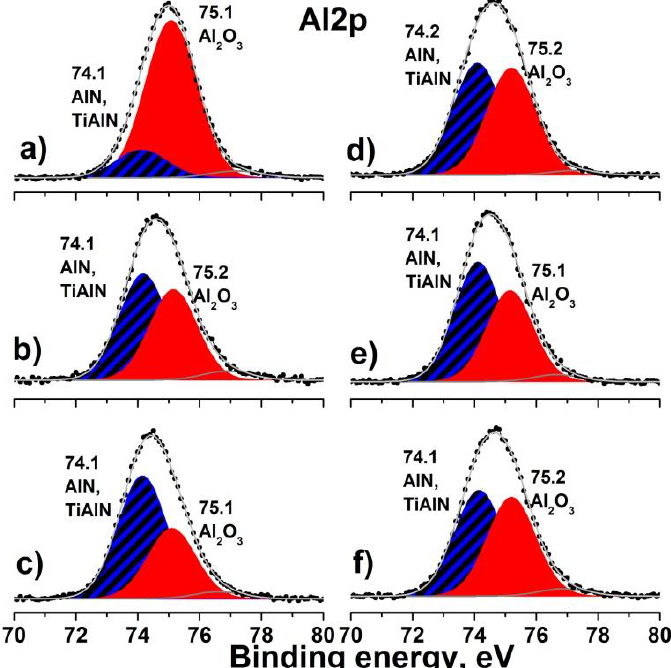
Figure 4. Al2p XP-spectra obtained for Ti-Al-N films ( a ) 200 ◦ C, 20 sccm; ( b ) 200 ◦ C, 40 sccm; ( c ) 200 ◦ C, 60 sccm; ( d ) 500 ◦ C, 20 sccm; ( e ) 500 ◦ C, 40 sccm and ( f ) 500 ◦ C, 60 sccm after Ar + ion etching.